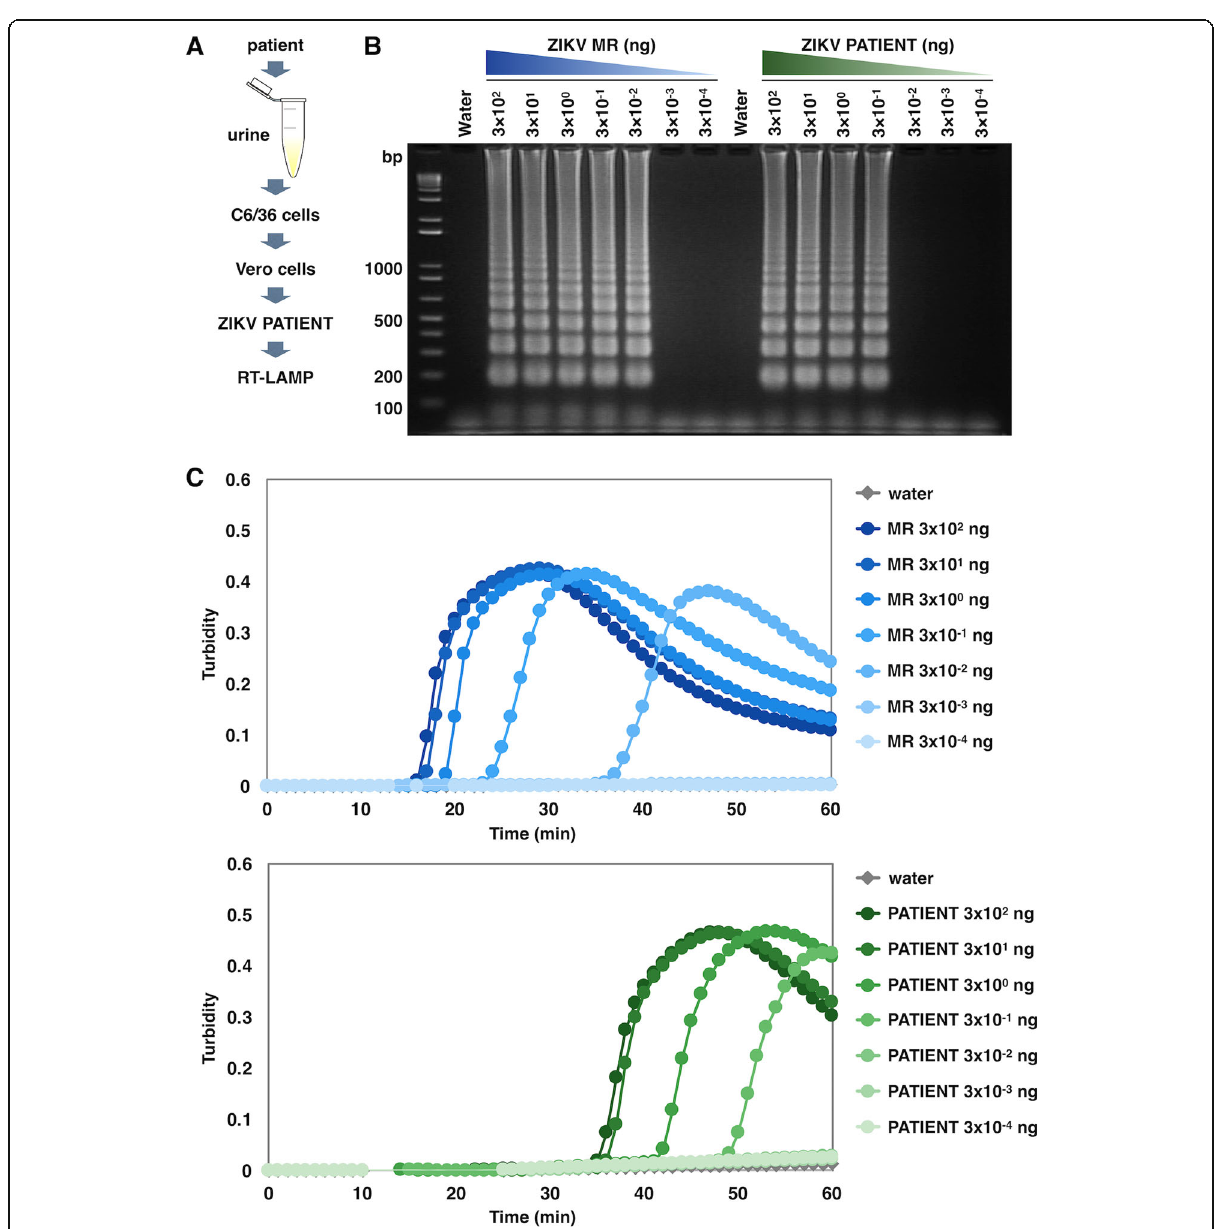
Fig. 4 Sensitivity of RT-LAMP for the detection of ZIKV from Zika fever patient. a Scheme for preparing the ZIKV PATIENT strain from patient ’ s urine for RT-LAMP detection. b , c Amplification of ZIKV NS3 from the MR and PATIENT strains by RT-LAMP. RNA of each ZIKV strain (3 × 10 2 , 3 × 10 1 , 3 × 10 0 , 3 × 10 − 1 , 3 × 10 − 2 , 3 × 10 − 3 , and 3 × 10 − 4 ng) was used as a template for RT-LAMP reactions for 60min at 62°C. Water served as a negative control in the RT-LAMP reaction. b Agarose gel electrophoresis of the RT-LAMP amplified products. The reaction mixtures were electrophoresed on a 2% agarose gel. Numbers of the left indicate migration of the molecular weight marker (bp). c Amplification of the target sequence of the MR and PATIENT strains was monitored using a real-time turbidimeter (turbidity at